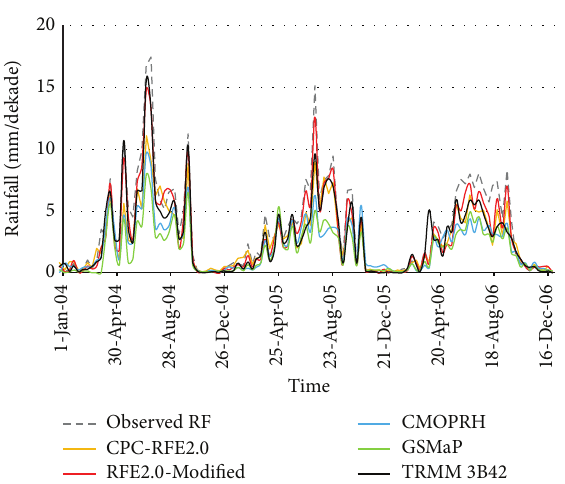
Figure 11: Time series of basin average dekadal rainfall for different satellite rainfall products from 2004 to